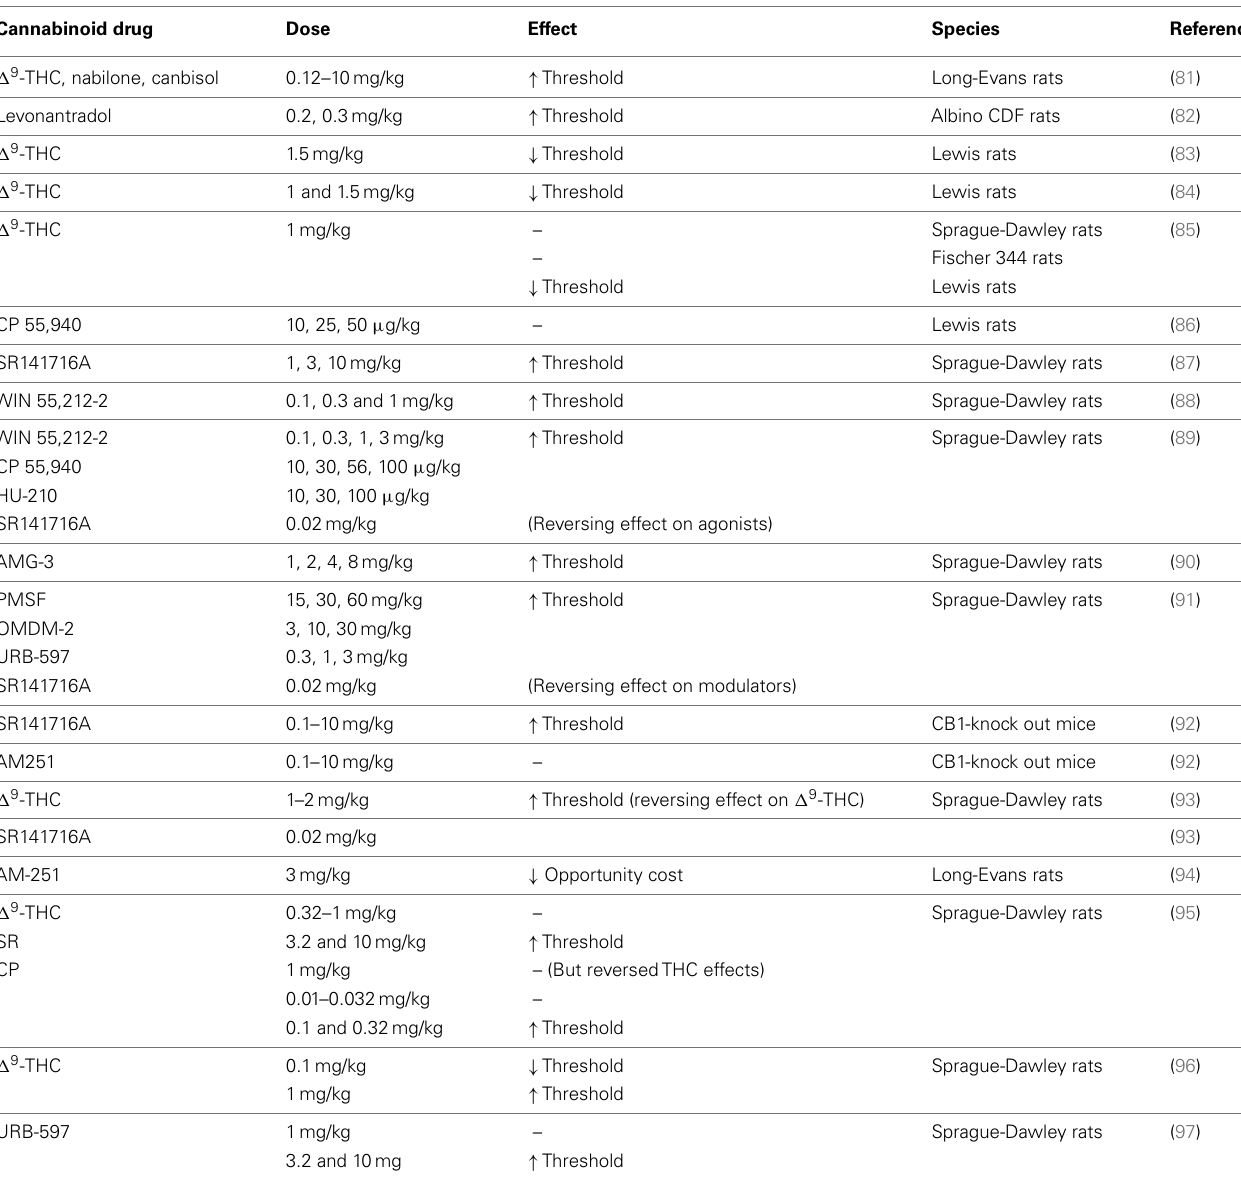
Table 1 | Cannabinoid effect on intracranial self-stimulation in experimental animals . Cannabinoid drug Dose Effect Species